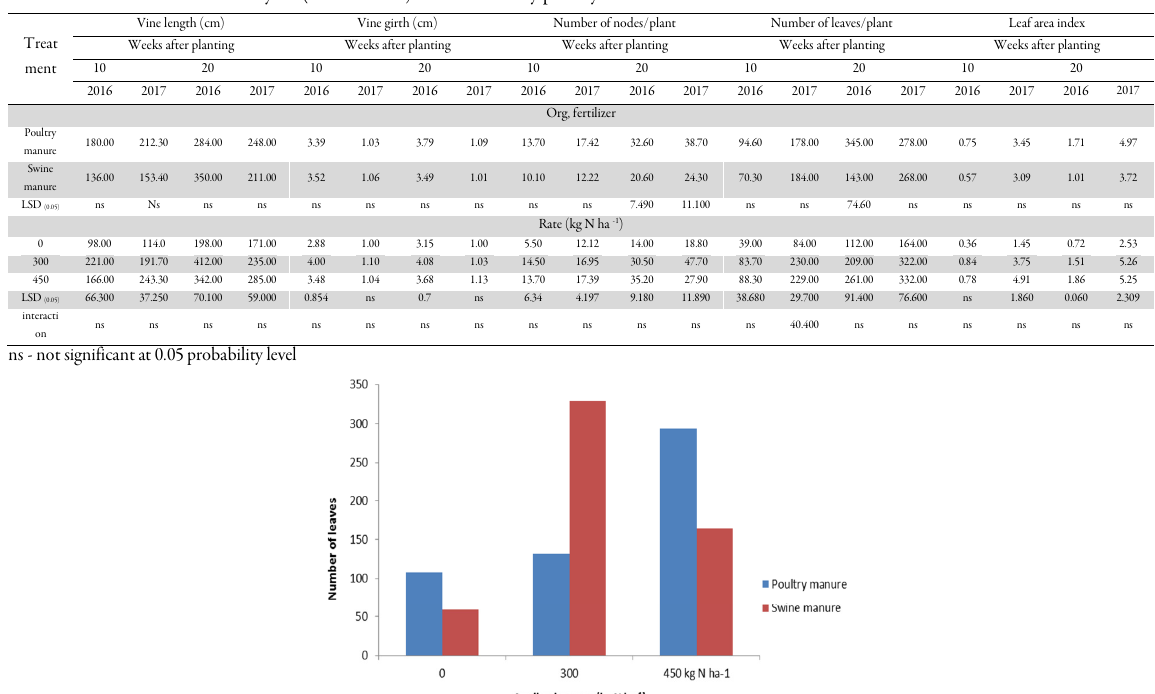
Table2. Growth of white Guinea yam ( D. rotundata ) as influenced by poultry and swine manure Vine length (cm) Vine girth (cm) Number of nodes/plant Number of leaves/plant Leaf area index Treat Weeks after planting Weeks after planting Weeks after planting Weeks after planting Weeks after planting ment 10 Poultry manure